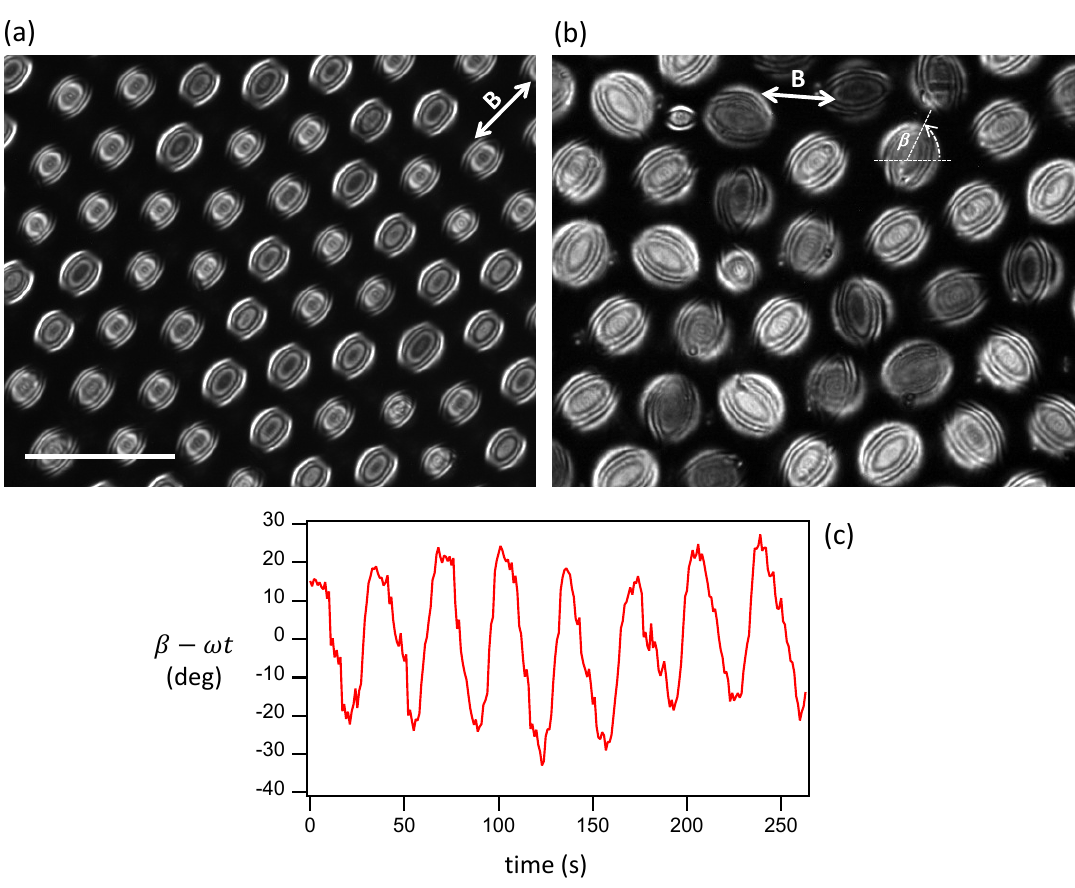
Figure 7. Emulsified SSY droplets during magnetic field rotation at 10 deg s − 1 ( a ) and 7.2 deg s − 1 ( b ). While small droplets are able to follow the rotation rate (a, and Movie 4) larger droplets lag behind, and feature asynchronous oscillations (b and Movie 5). The instantaneous orientation of the rotating field is overlaid on each image. Scale bar is 100 µ m. ( c ) Oscillation of the orientation of the droplet axis, β , with respect to the rotation angle, ω t , for a sample droplet, where ω is the angular